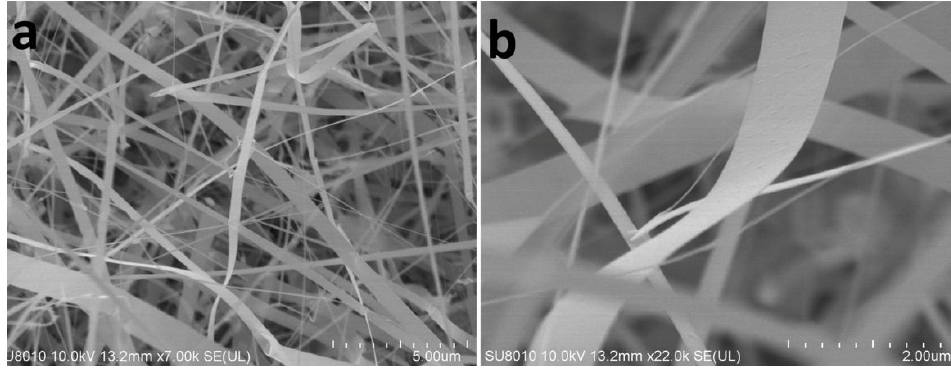
Figure 2. The SEM image of the as-grown CdS nanobelts.